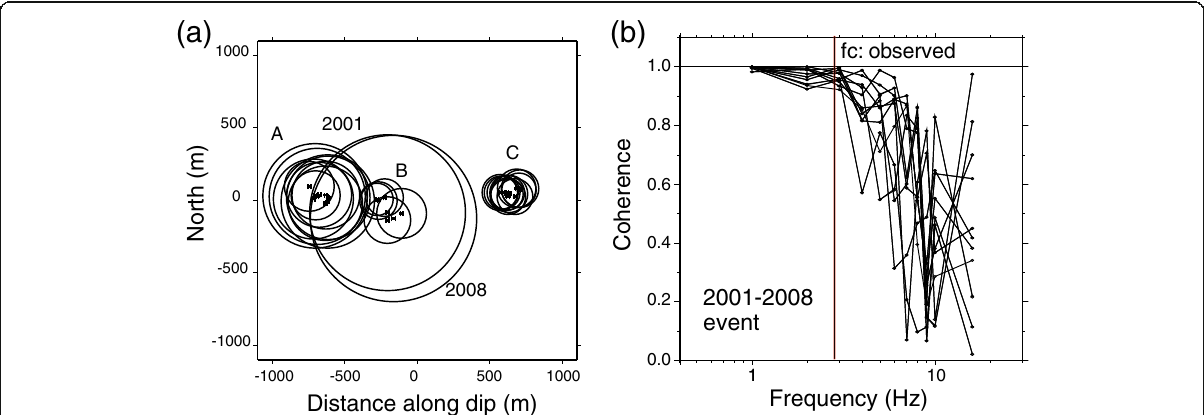
Fig. 4 a Slip area distribution in the off-Kamaishi earthquake cluster. Circle size denotes rupture dimension estimated from corner frequencies. Small bars show centroid location uncertainties. The labels 2001 and 2008 indicate M~ 4.8 repeating earthquakes in those years. The earthquakes labeled A – C are events with magnitudes 2.4 – 3.6 that occurred from 1995 to 2008. This figure is modified from Uchida et al. (2012). b Coherence dependence on frequency for the waveforms of the 2001 and 2008 M~ 4.8 repeating earthquakes for 11 stations. A time window of 40 s was used for the calculation. The vertical line shows the observed corner frequency from spectral ratio analysis (Uchida et al. 2012)